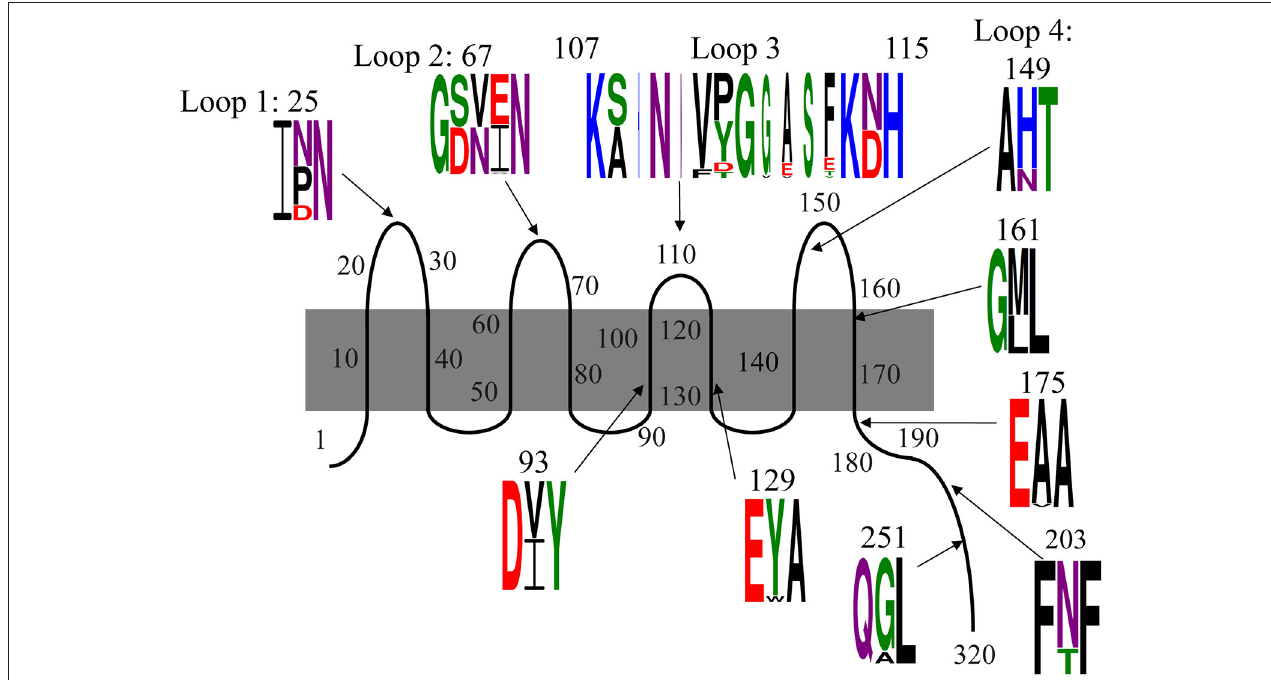
FIGURE 4 | Polymorphisms within OmpA among our 78 E. coli isolates. Residues are numbered and classified according to the description by Pautsch and Schulz (1998) and Marcoux et al. (2014). Residues 22–28, 65–68, and 147–157 were previously classified by Pautsch and Schulz (1998) as “highly mobile” regions of loops 1, 2, and 4, respectively and residues 188–276 were identified by Marcoux et al. (2014) as the dimerization domain. Two polymorphisms in the C-terminal domain were observed only in one isolate each and are not shown here, but are described in the text. Sequence logos were generated with Weblogo 3.5.0, with letter height representing probability. Colors indicate amino acid chemistry, with polar residues shown in green, neutral residues in purple, basic residues in blue, acidic residues in red and hydrophobic residues in